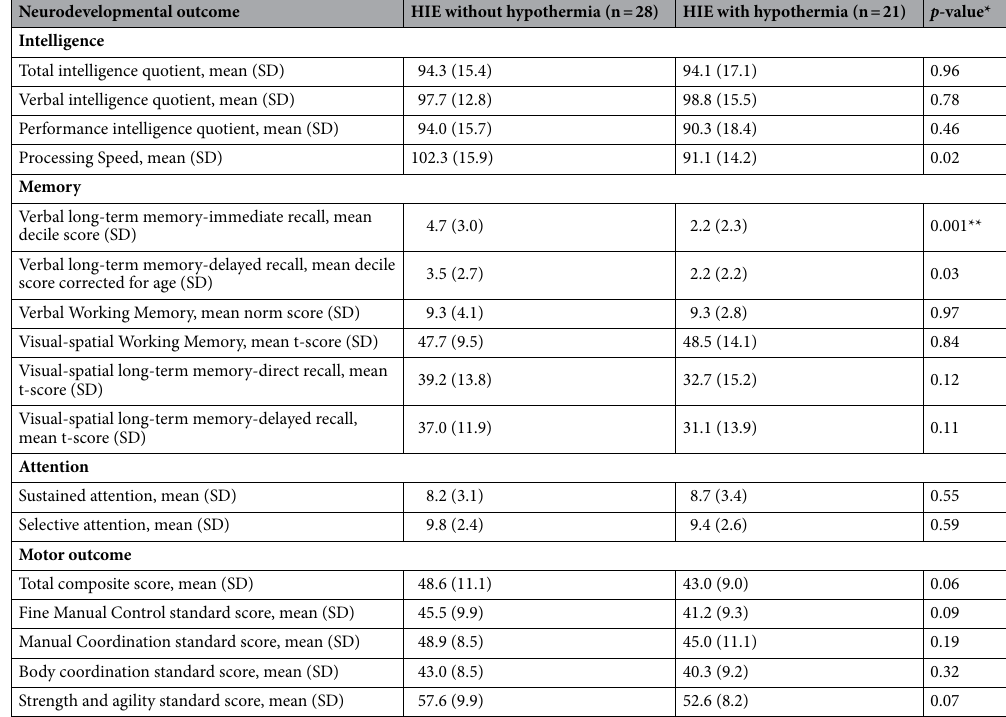
Table 2. Neurodevelopmental outcome. *For the outcomes of the neuropsychological assessments, after correction for multiple comparison, p -values < 0.004 were statistically significant. For the motor outcome, p -values < 0.01 were statistically significant. **Statistically significant.